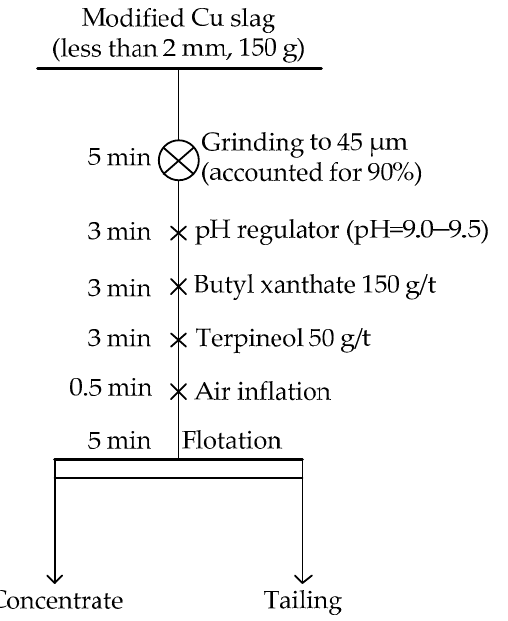
Figure 6. Flotation flowsheet of modified slag.